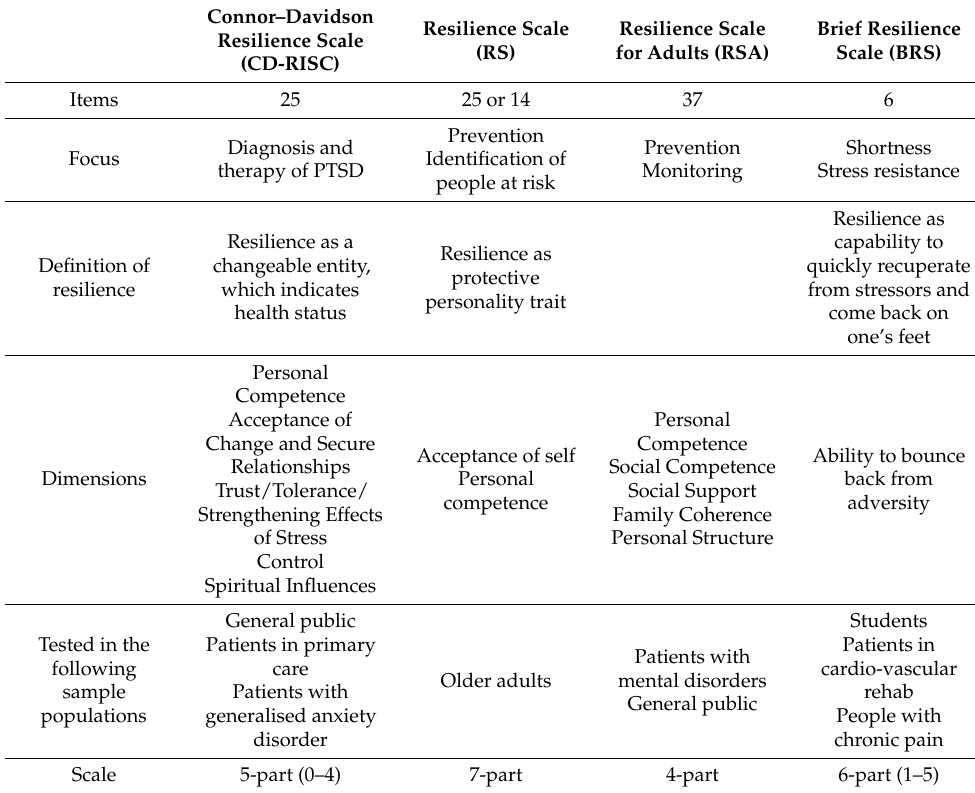
Table 2. Overview of resilience assessment